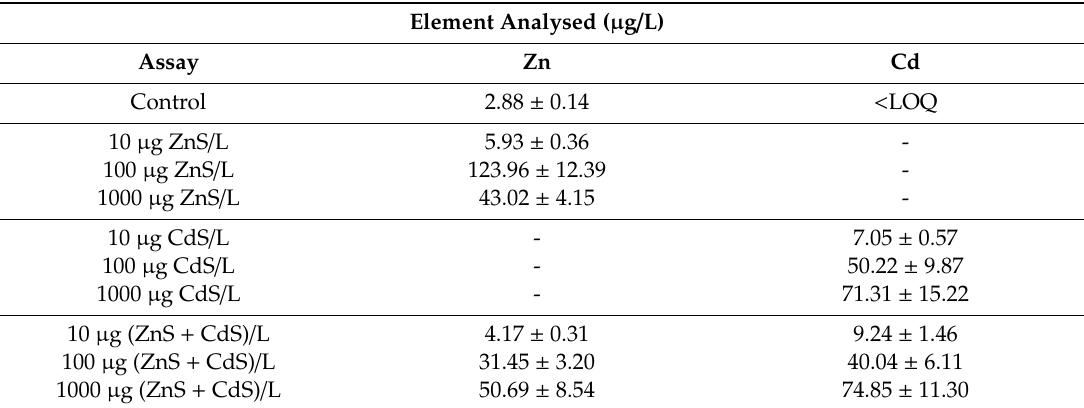
Table 2. Results from ICP-AES analysis of Zn and Cd in water samples. Element Analysed ( µ g / L)